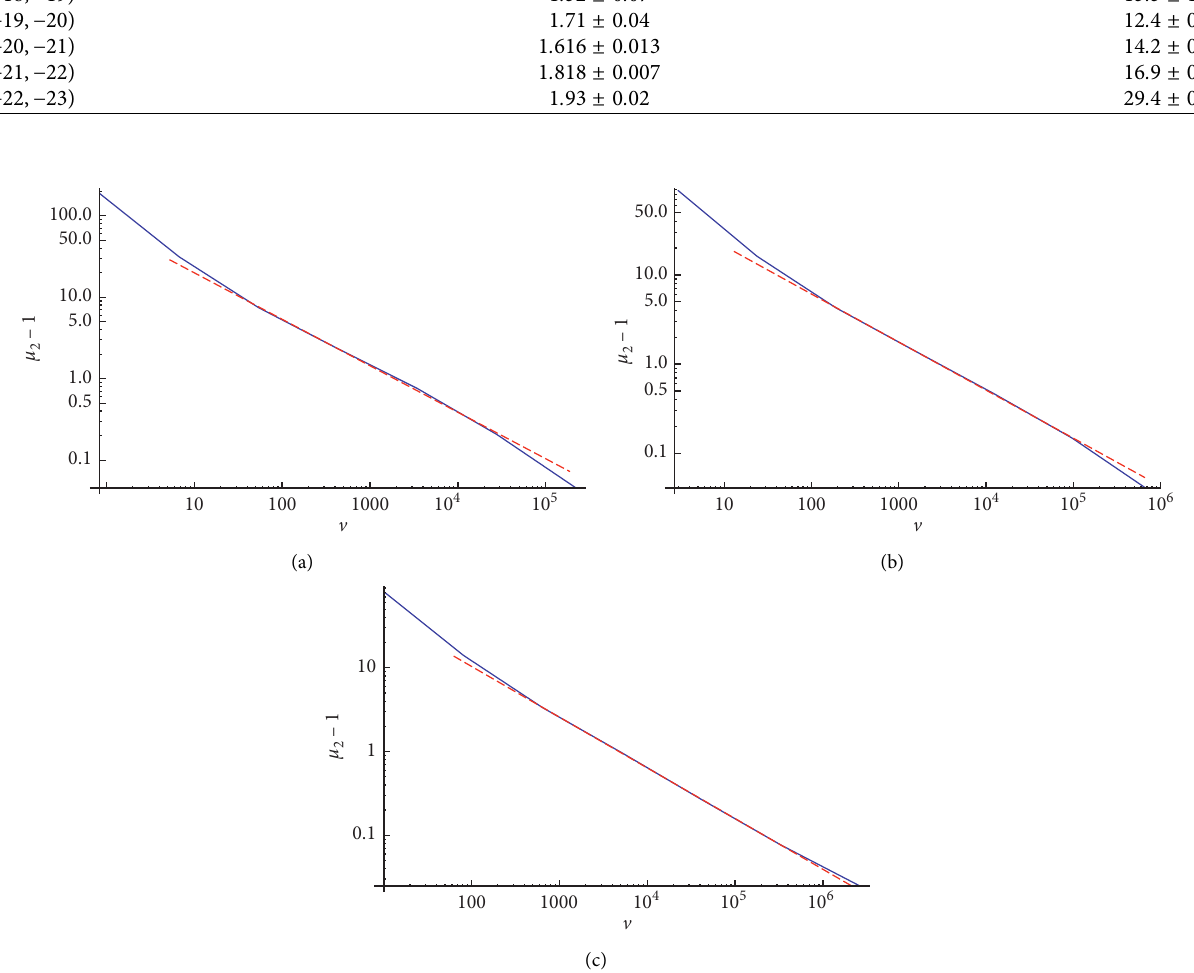
Figure 2: Variance μ ( v ) − 1 of the stellar mass distribution ( v in Mpc 3 /h 3 ), for three volume-limited samples: M 2 (− 20 , − 21 ) (b), and M (− 21 , − 22 ) (c). The linear fits yield the values of c and v 1/3 M r ∈ r ∈